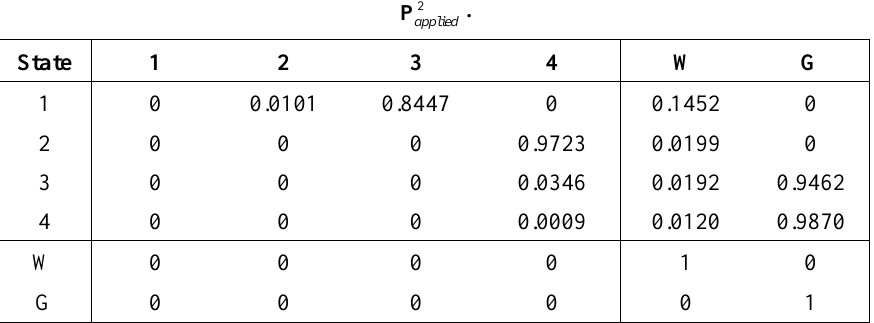
Table 16. The estimated transition probabilities matrix of applied sciences program for